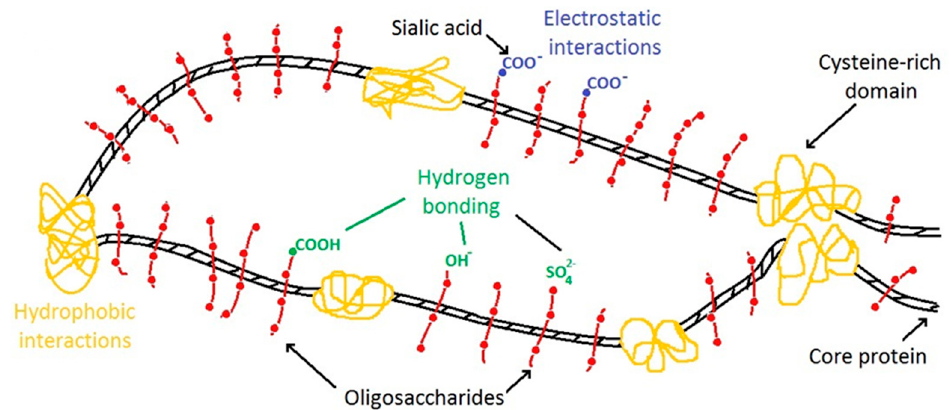
Figure 1. Schematic structure of mucin glycoproteins and their potentially mucoadhesive elements. More details can be found in [16].